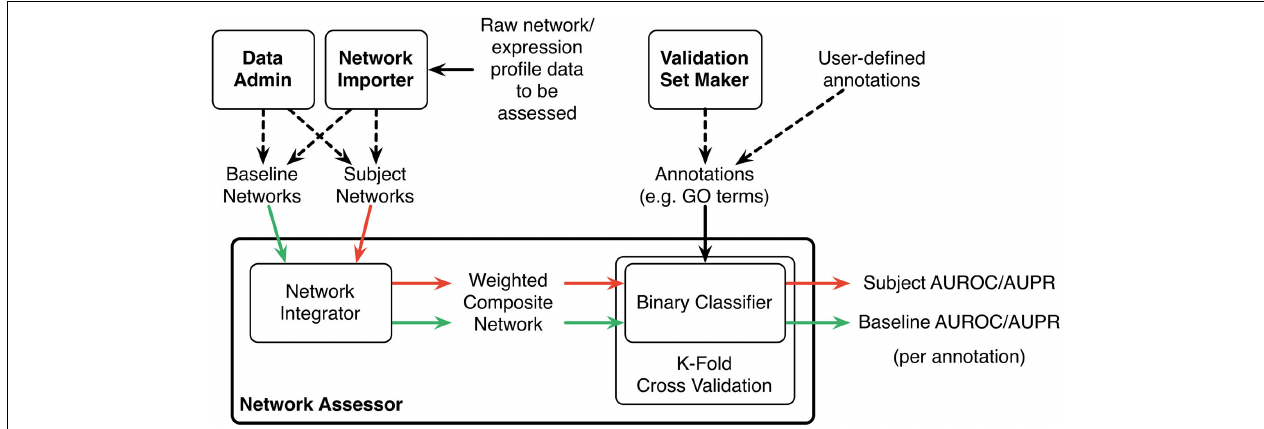
FIGURE 1 | Schematic diagram of the Network Assessor workflow. The green arrows indicate the first round of cross validation. Red arrows are second round. AUROC/AUPR statistics are computed for each node label (e.g., GO term) for each round of cross validation. Dashed lines indicate alternative